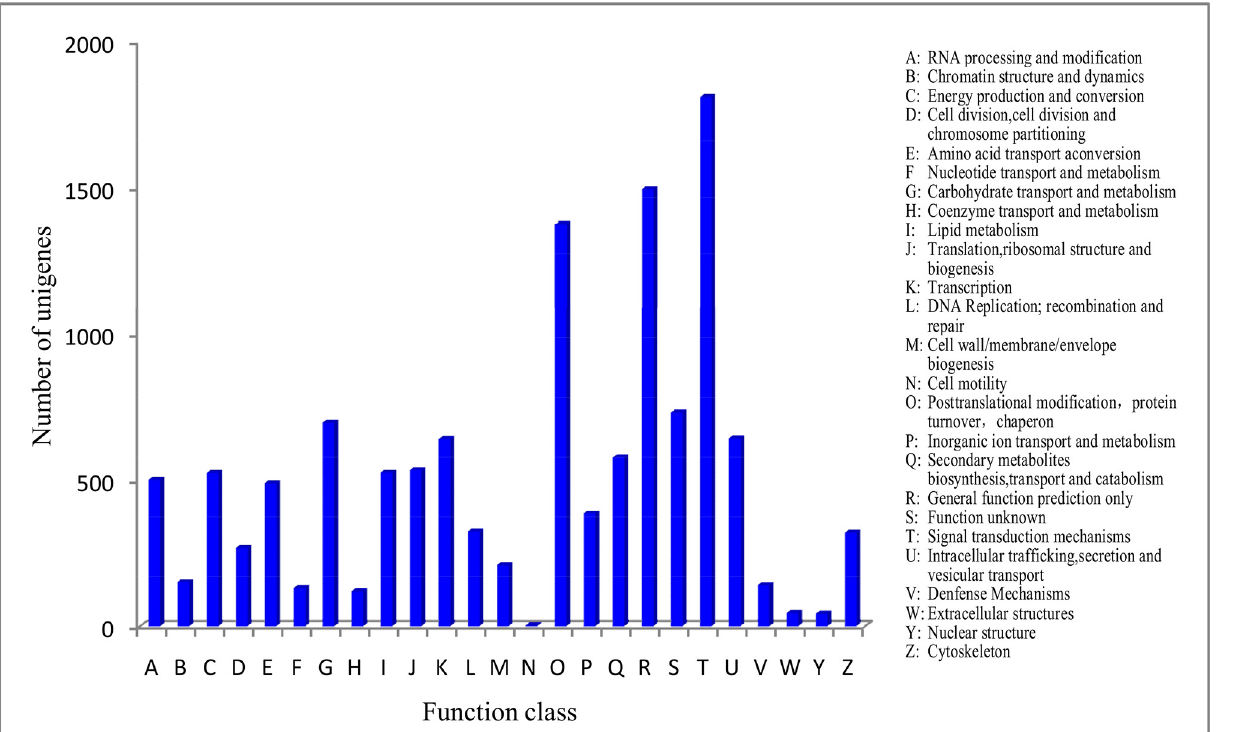
Fig 6. KOG function classification of unigenes.